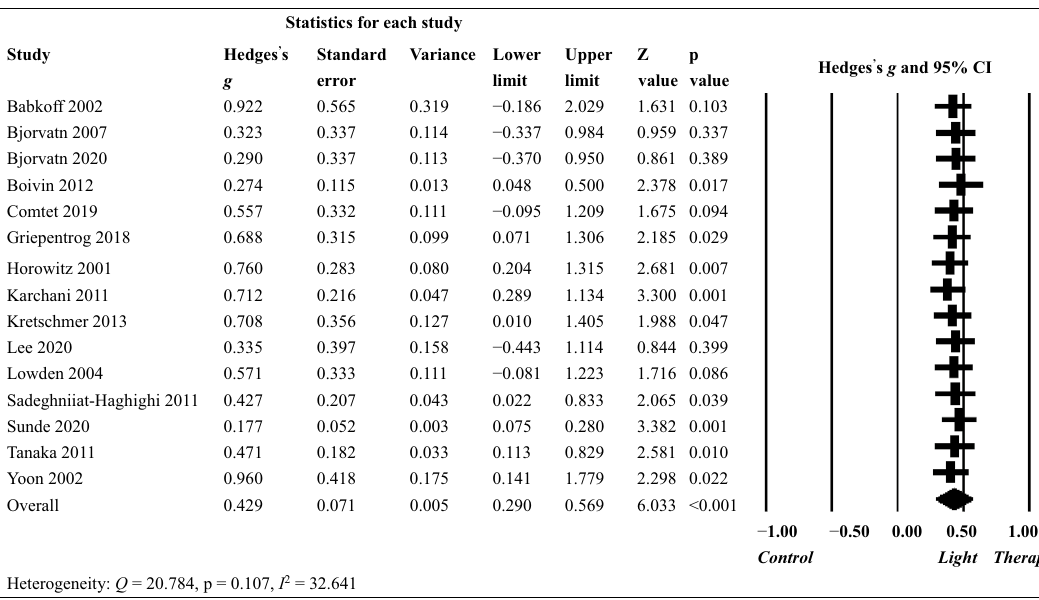
Figure 2. Treatment effect of light therapy on sleepiness in shift workers analyzed using a random-effects